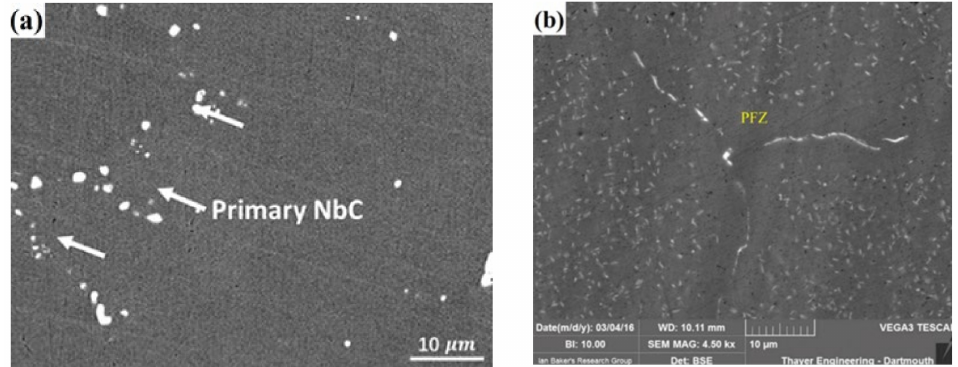
Figure 5. ( a ) BSE images showing the microstructure of solution treatment AFA-1 [61]; ( b ) BSE images of Fe-20Cr-30Ni-2Nb-5Al solution treatment at 1250 ◦ C for 24 h and annealed for 24 h at 800 ◦ C after creep testing for 500 h